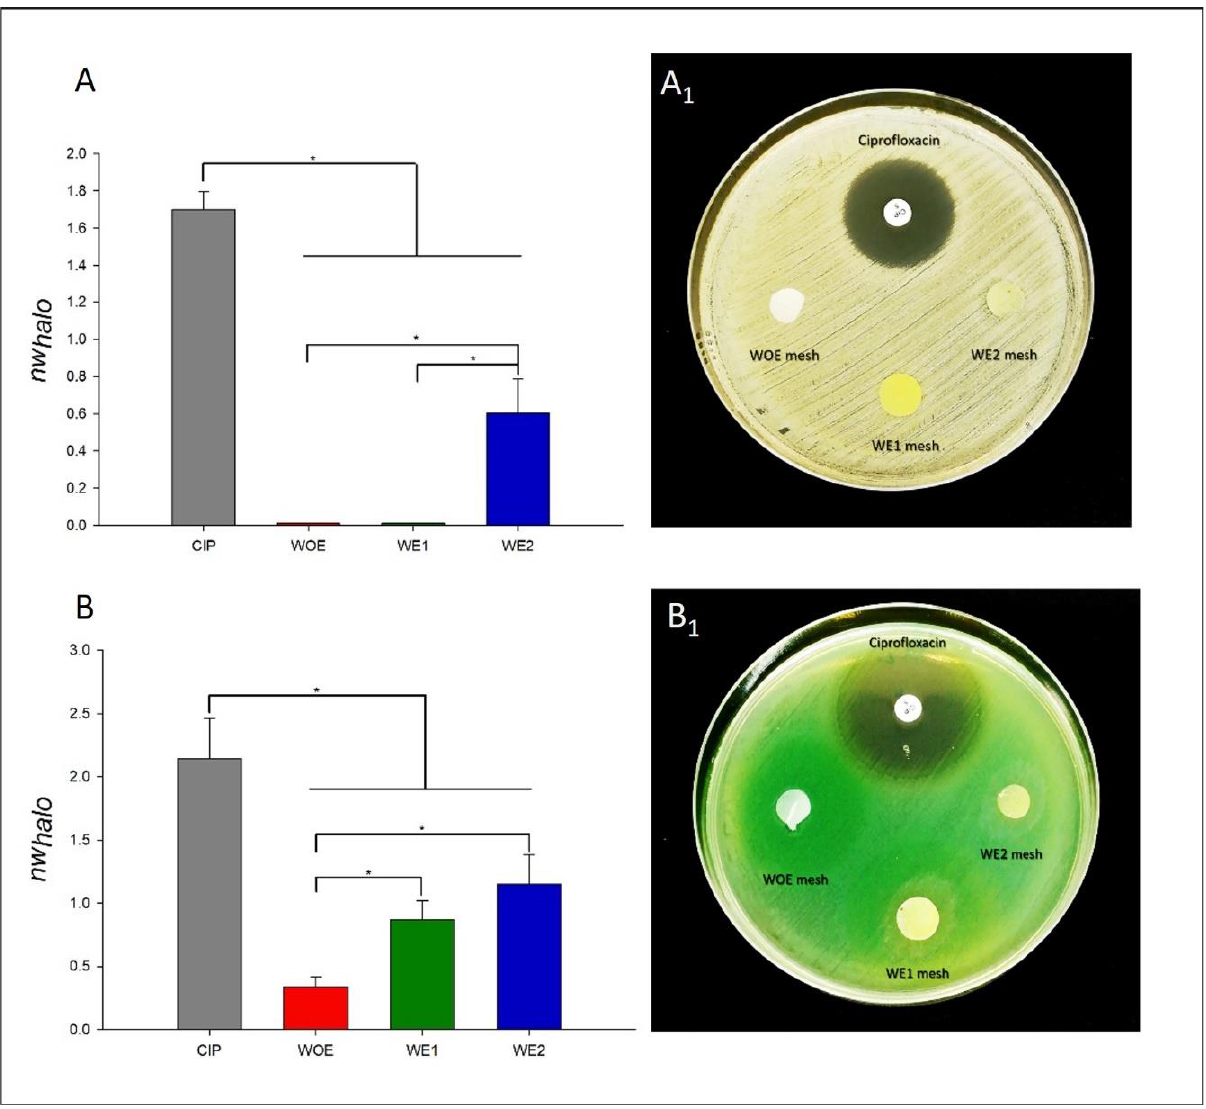
Figure 4. Measurements of the normalized “ halo ” ( nw halo ) for WOE, WE1, and WE2 disc, compared with the control conditions, the antibiotic (ciprofloxacin- CIP) against Staphylococcus aureus ( A ) and the photo of the disc assay ( A 1 ). Measurements of the normalized “ halo ” ( nw halo ) for WOE, WE1, and WE2 disc, compared with the control conditions, the antibiotic (ciprofloxacin- CIP) against Pseudomonas aeruginosa ( B ) and the photos of the disc assay ( B 1 ). The differences are statistically significant with p < 0.05, (*).